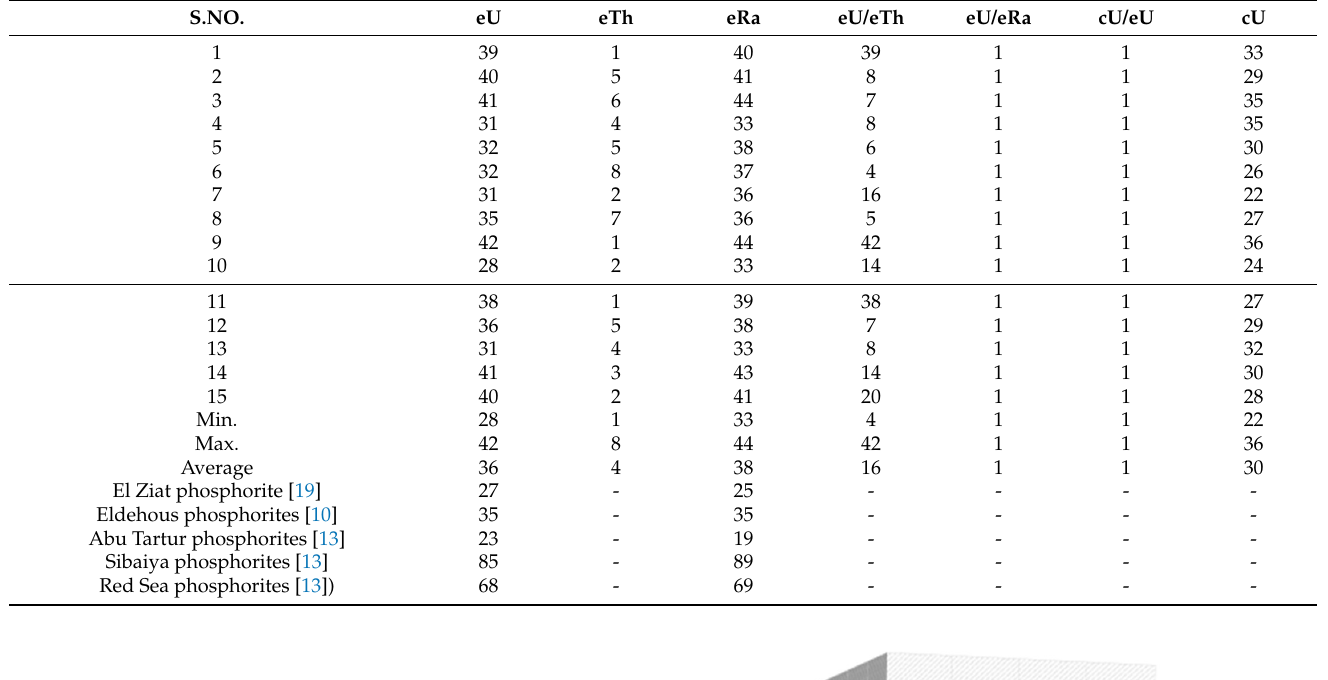
Table 3. Radiometricmeasurements(ppm)oftheexaminedphosphoritescomparedwithotherphosphorites.